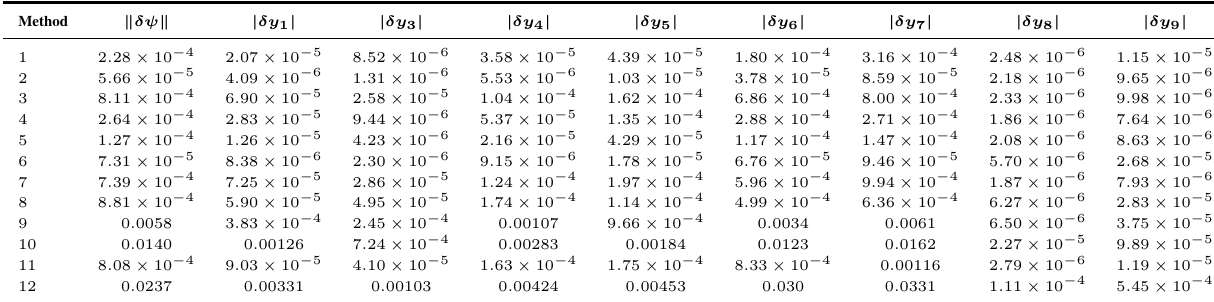
Table 1. Comparison of reduced and detailed solution trajectories (with initial condition u = [0 , 0] and 0 ≤ t ≤ ¯ t = 1 × 10 − 4 [ s ] ) corresponding to several schemes implementing lifting and restriction operators (see the text). (cid:107) δψ (cid:107) indicates the mean deviation between the reduced and detailed solution trajectory (in the reduced